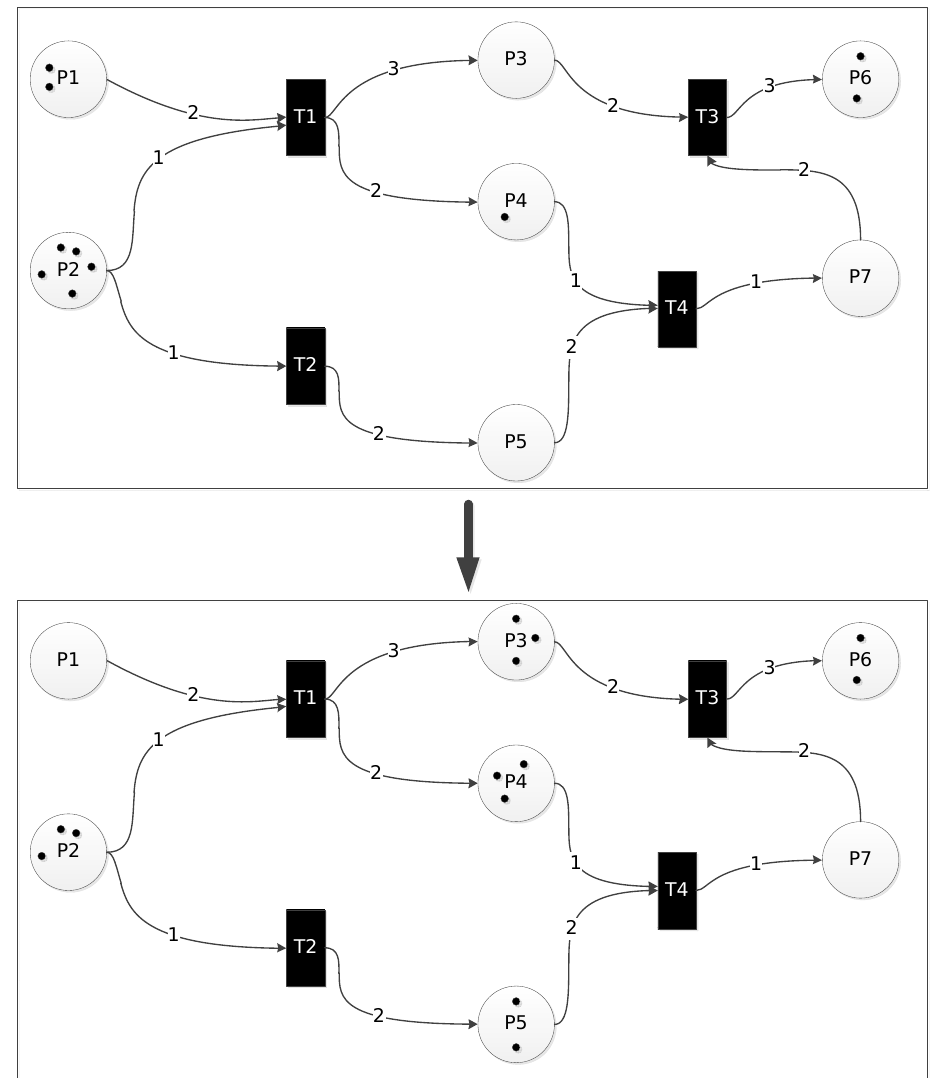
Figure 1: Petri Net example, top: the Transitions (cid:2176)(cid:2778) and (cid:2176)(cid:2779) are ready to fire, bottom: the new state of the Petri Net after firing Transition (cid:2176)(cid:2778) and (cid:2176)(cid:2779)